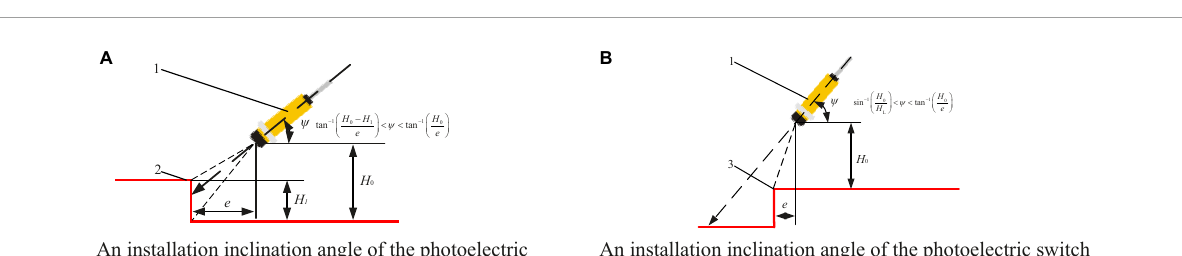
FIGURE3 A layout principle of a photoelectric switch to identify the road edge: (1) A photoelectric switch, (2) A raised road edge, (3) A sunken road edge, e . A safety distance between the autonomous navigation platform and the curb line during driving (mm), H 0 . Height of the photoelectric switch installed on the mobile platform (mm), H 1 . Height of the raised curb (mm), H L . A range set by the photoelectric switch (mm), ψ . An inclination angle between a photoelectric switch and a road edge ( ◦ ).